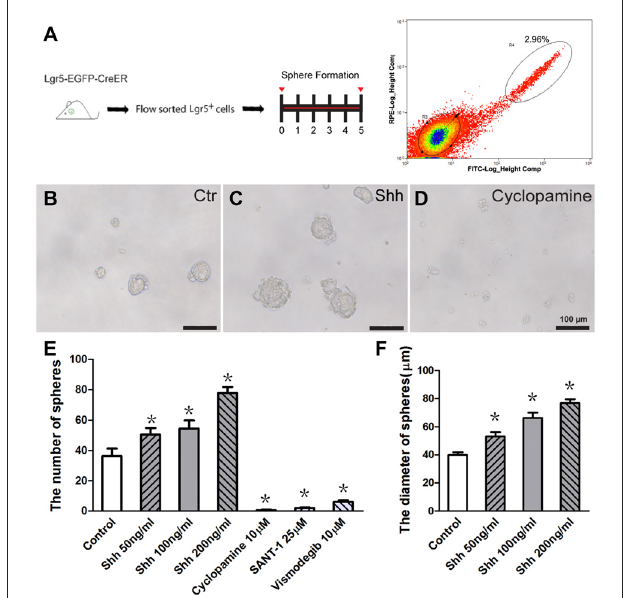
FIGURE 1 | Hedgehog signaling significantly enhanced the sphere-forming ability of isolated postnatal Lgr5+ progenitor cells in vitro . (A) Diagram of the FACS and sphere-forming assay. (B–D) Representative images of Lgr5+ spheres in the control (B) , Sonic Hedgehog (Shh) protein-treated ( C , 100 ng/ml) and cyclopamine-treated ( D , 10 µ M) groups. (E) The number of spheres increased significantly in the Shh protein-treated group and decreased significantly in the Hedgehog antagonist (cyclopamine, SANT-1, or vismodegib)-treated groups compared to the control group. (F) The average diameter of the spheres significantly increased in the Shh protein-treated group compared to the control group. Data are presented as means ± SE. N = 5, ∗ p < 0.05 vs. the control group. Scale bars (B–D) are 100 µ